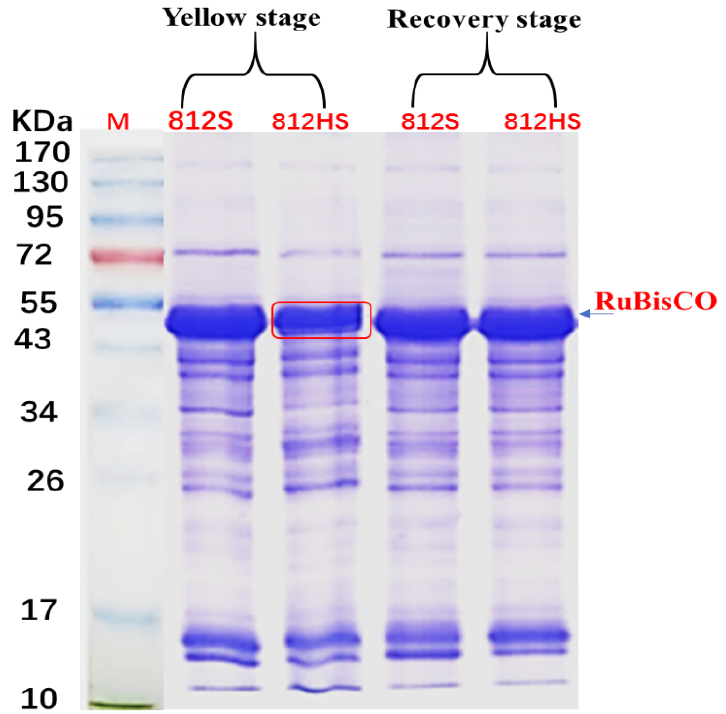
Figure 8. Effects of photooxidation on the protein of leaves in 812S and 812HS by